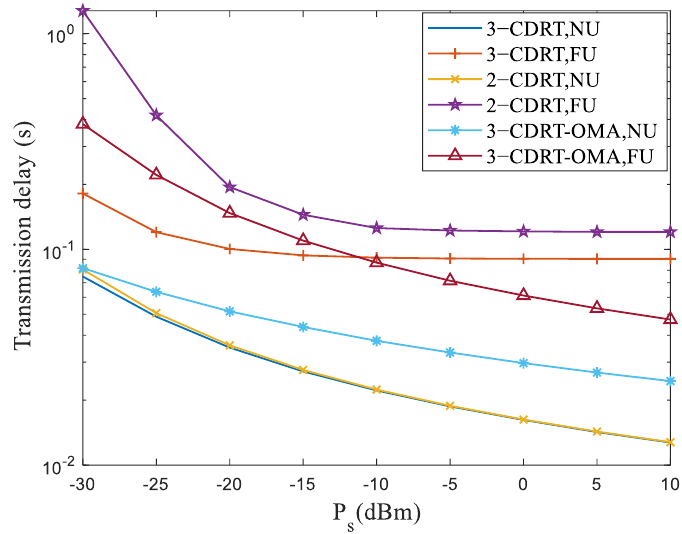
Figure 6. Comparison among the proposed 3 − CDRT strategy, the 2 − CDRT strategy and the 3 − CDRT − OMA strategy in terms of the transmission delay with varying P s (dBm).